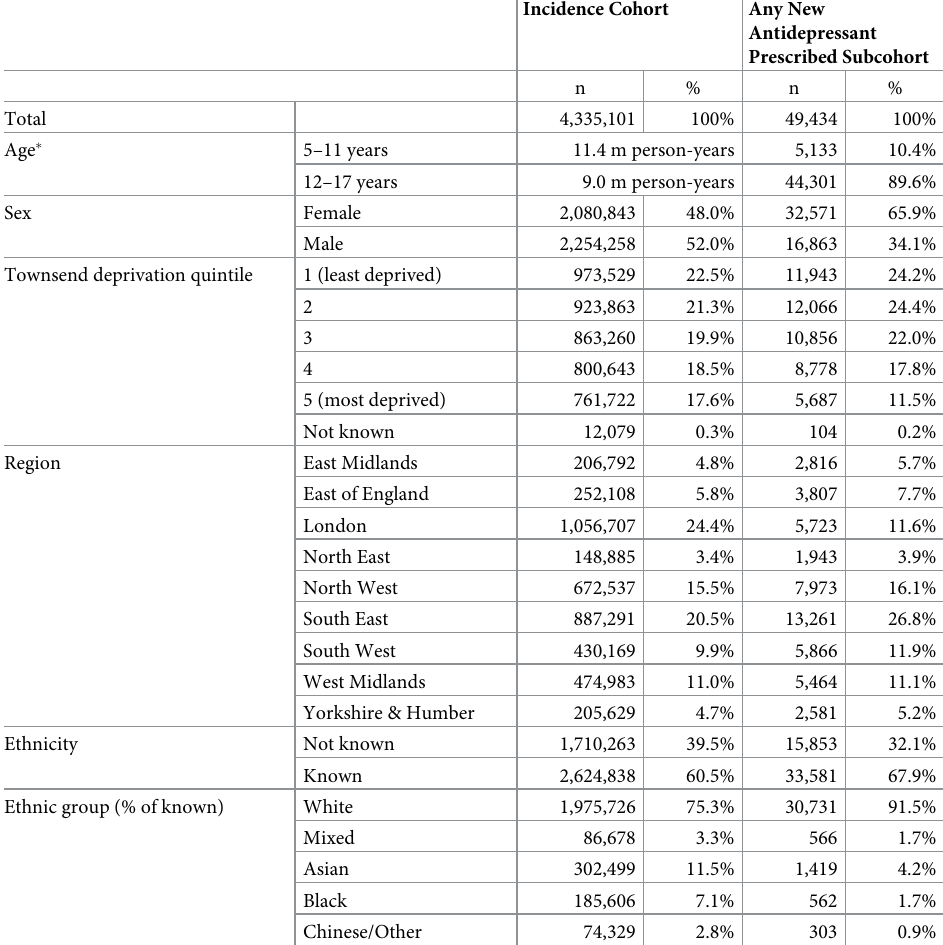
Table 1. Characteristics of incidence cohort (incidence cohort excludes 14,537 patients with first antidepressant prescription before study entry) and the subset with a new prescription of any antidepressant during the study period, age 5 to 17 years, England